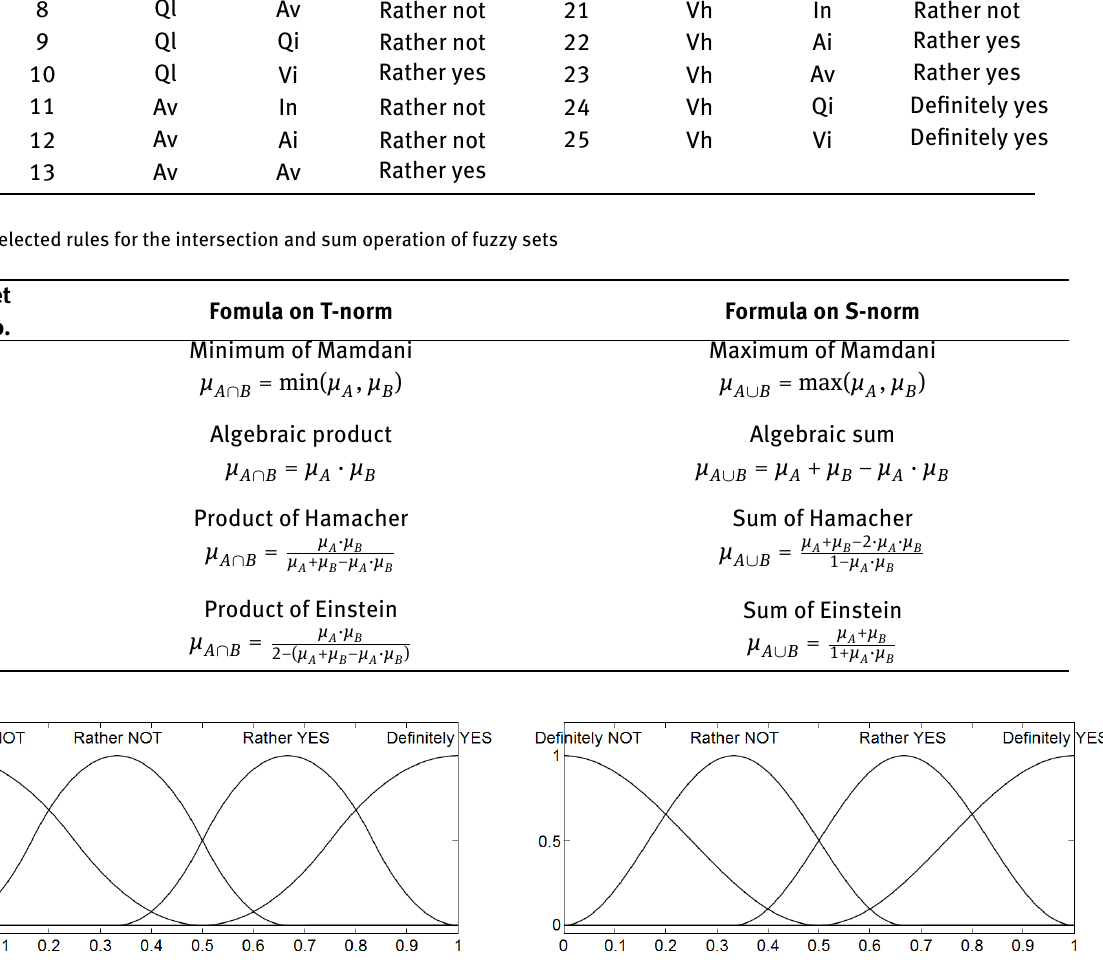
Figure 11: Membership function for the output variable y – IRF(Uph)